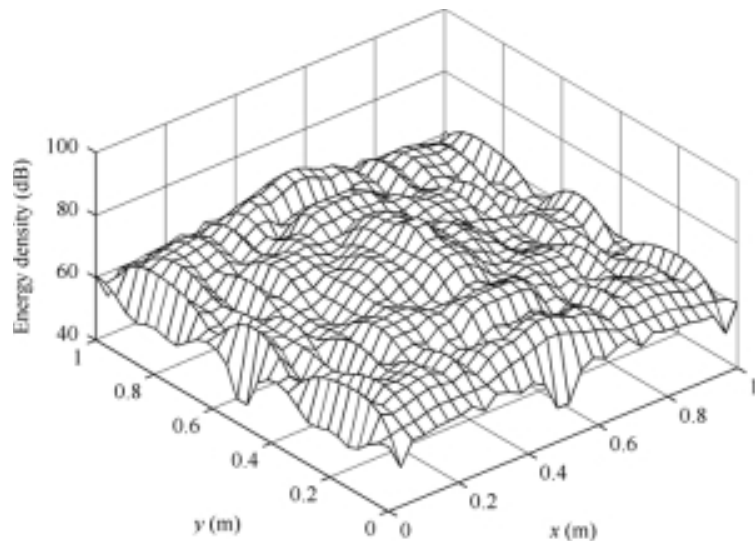
Fig. 7. The classical energy density distribution of the orthotropic plate when f = 500 Hz and η = 0 . 2 . The reference energy density is 1 × 10 − 12 J/m 2 .